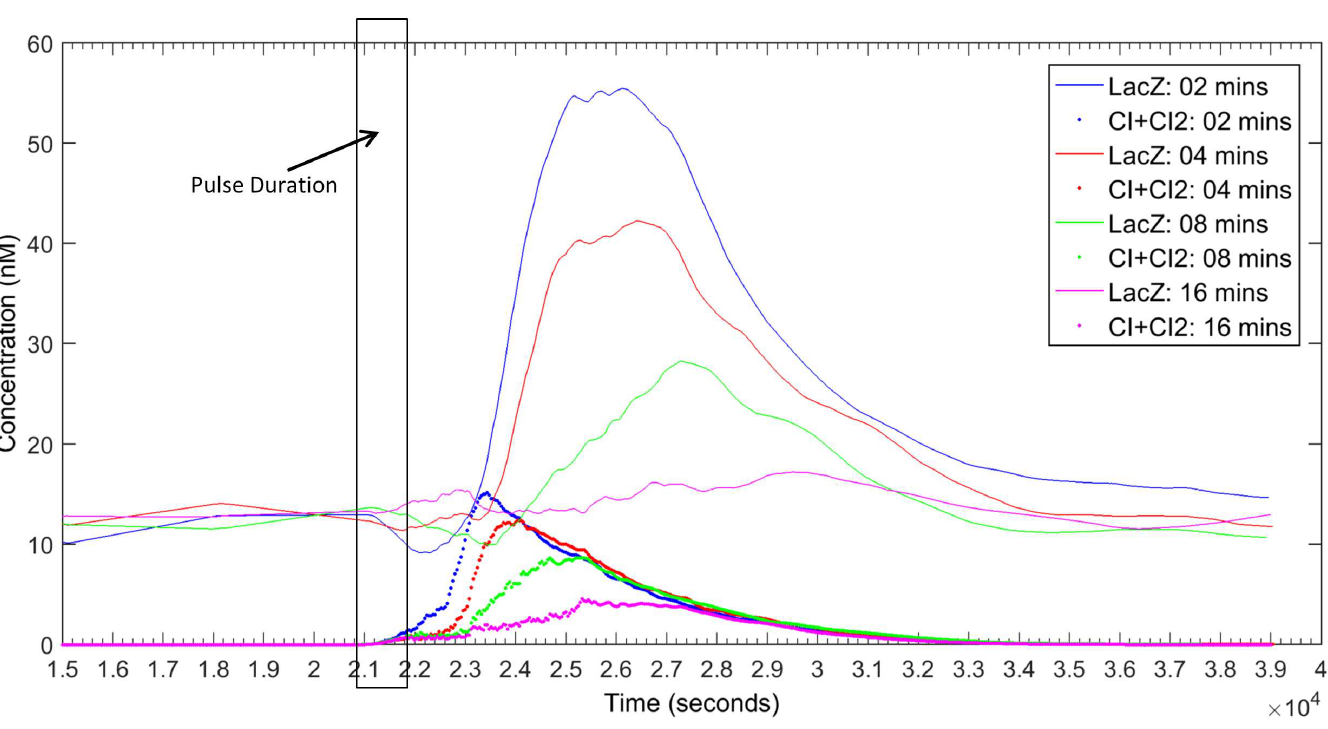
Fig 3. Response of the pulse detector circuit in Fig 1 with degradation tags of different half-lifes (2, 4, 8 and 16 minutes). For brevity only responses of LacZ and CI moleculeswere displayedfor each deg-tag using the same color. The pulse was activated at 10.2 CC (20808sec) and deactivatedat 10.7 CC (21828sec). The relative strength of RBS1 and RBS2 was 20:1. The responseis averageof 20 simulationruns.